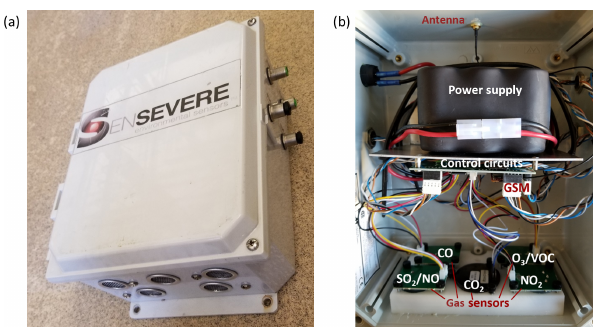
Figure 1. External (a) and internal (b) configuration of the RAMP